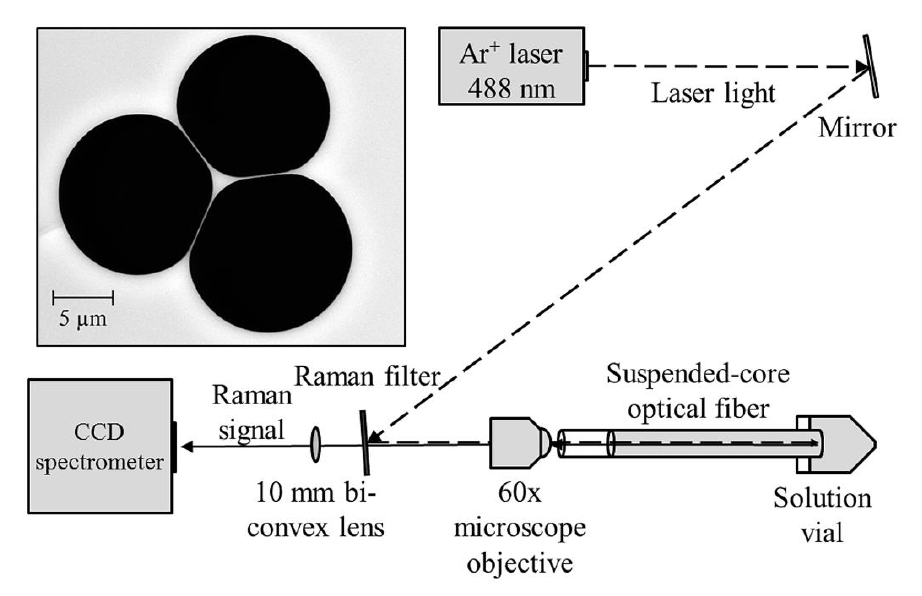
Figure 1. Experimental setup used for Raman measurements of explosives in suspended-core optical fibers. The reflection angle off the Raman filter has been exaggerated for clarity. The inset shows a scanning electron microscope image of the silica fiber used in the